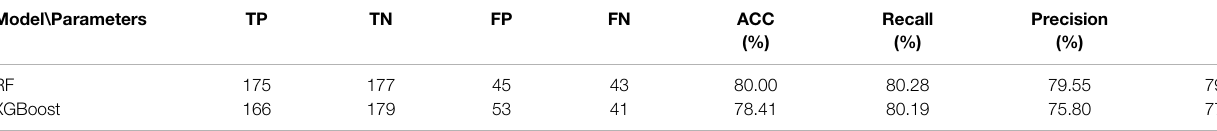
TABLE 2 | Confusion matrix of the RF and the XGBoost models. Model\Parameters